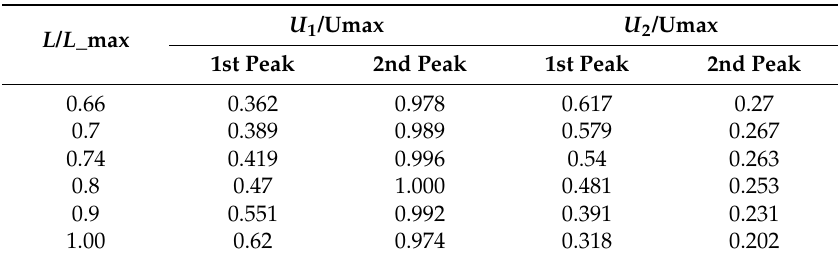
The influence of the normalized bimorph length on the normalized end mass amplitude—two bimorphs interconnected by a spring